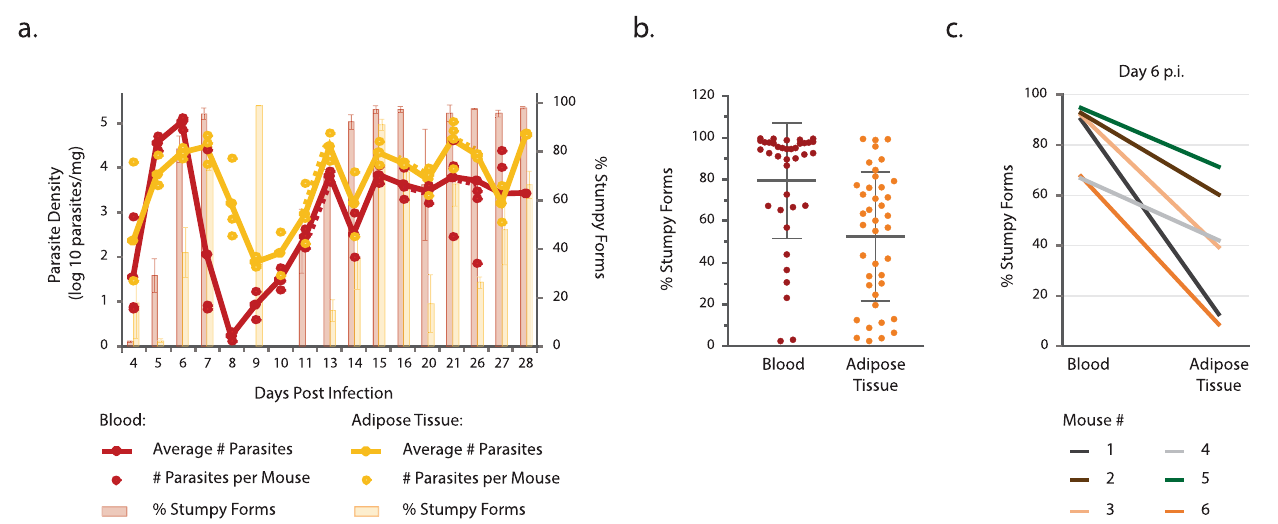
Fig.1|Infectiondynamicsinbloodandgonadaladiposetissue.a C57BL/6Jmice were infected with a pleomorphic T. bruce i GFP::PAD1 utr stumpy reporter cell-line. The number of parasites per milligram of tissue was quanti fi ed by qPCR (red and yellow lines and dots) and the percentage of stumpy forms was estimated by fl ow cytometry as the proportion of GFP-positive parasites (red and yellow bars). Parasite density: n =3 independent experiments for all time points, except for day 21 in which n =4 independent experiments. Percentage of stumpy forms: n =3 independent experiments for all time points, except for day 6 in which n =7 independent experiments and day 7 in which n =5 independent experiments. The dashed lines correspond to noncontiguous time points and the full lines to